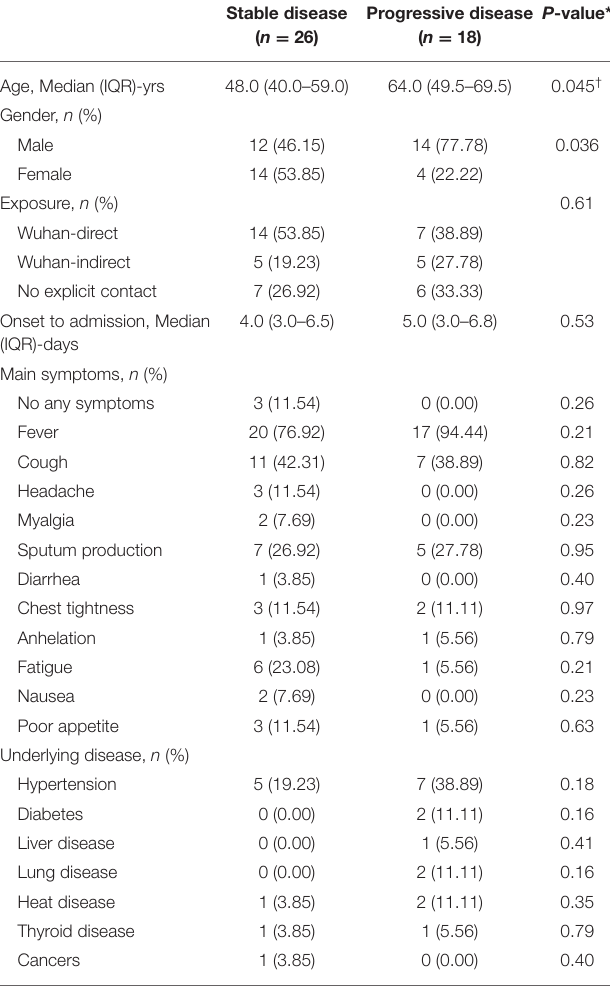
calcium level ( p = 0.0020) as well as significantly higher CRP ( p TABLE 3 | Baseline information of COVID-19 mild and moderate patients with or without progressive disease. with higher values of 5 other indicators ( Table 4 ). Factors such P -value* Stable disease Progressive disease as people of an old age (older), man, and significantly higher ( n = 26) ( n = 18) or lower value in one of the above laboratory indicators